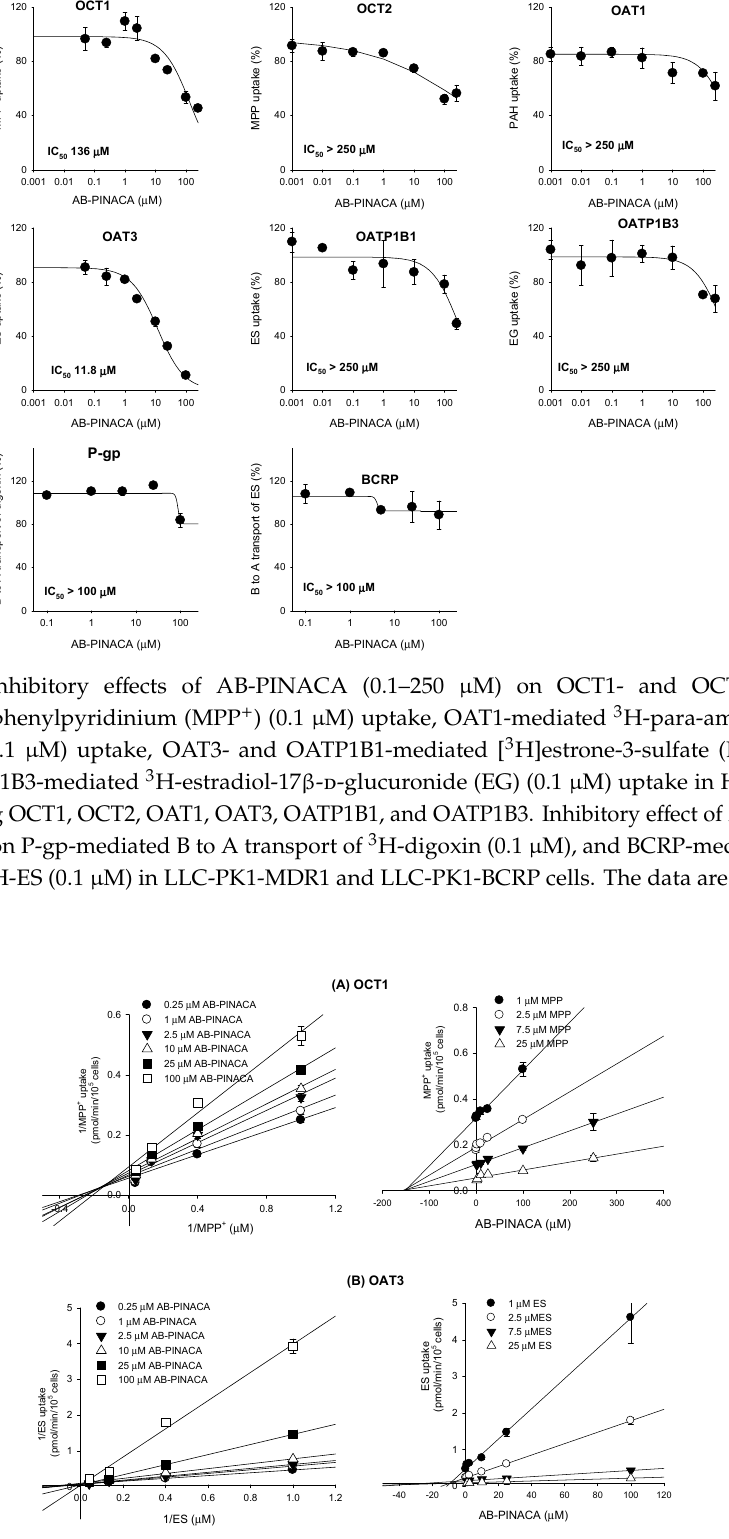
Figure 6. Lineweaver–Burk ( left panel) and Dixon ( right panel) plots for the inhibitory effects of AB-PINACA (0.25–100 µM) on ( A ) OCT1-mediated 3 H-methyl-4-phenylpyridinium (MPP + ) uptake and ( B ) OAT3-mediated 3 H-esrone-3-sulfate (ES) uptake in the presence of varying concentrations of MPP + or 3 H-estrone-3-sulfate (1, 2.5, 7.5, and 25 µM each) in HEK293-OCT1 and HEK293-OAT3 cells, respectively. Each symbol represents the concentration of AB-PINACA. Data are means ± SD ( n = 3). Table 2. Summary of mode of inhibition and inhibition constant ( K i ) of AB-PINACA on CYPs and transporters.